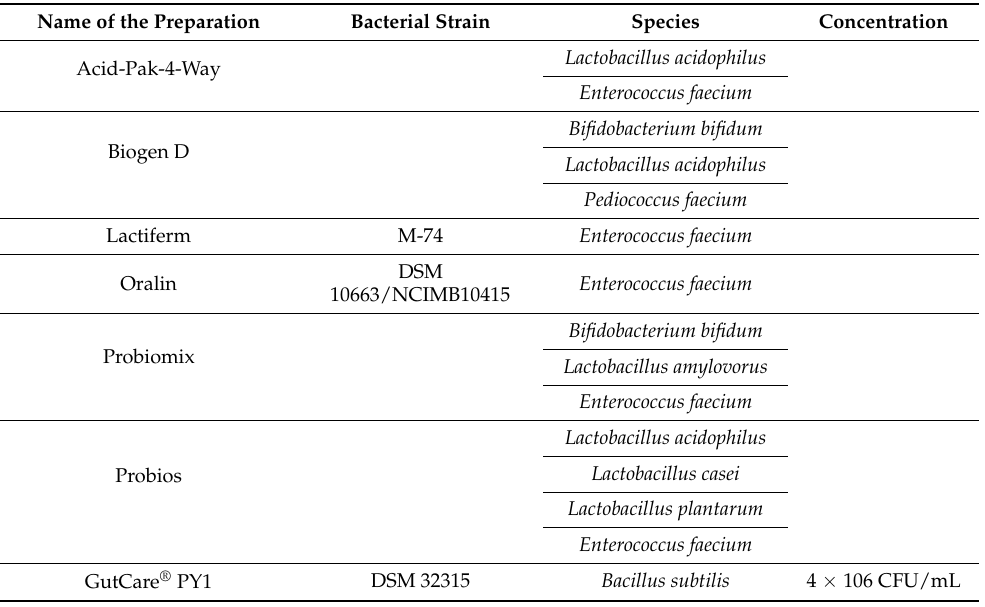
Table 1. Examples of probiotic preparations and strains used